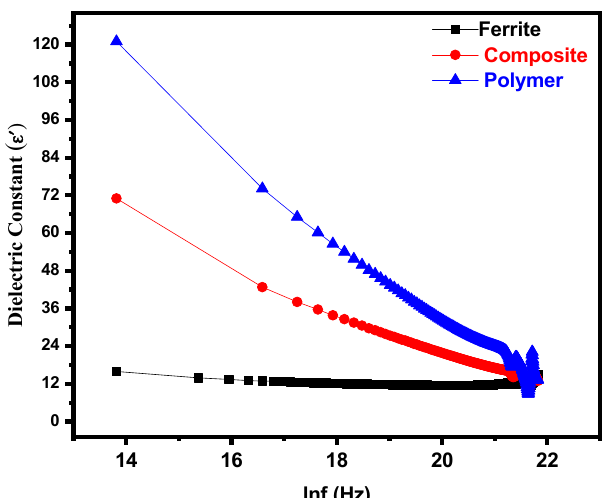
Figure 2. The dielectric constant of Y-type hexaferrite Sr 2 Co 2 Fe 12 O 22 , composite (Sr 2 Co 2 Fe 12 O 22 + PPy-DBSA) and polymer PPy-DBSA.